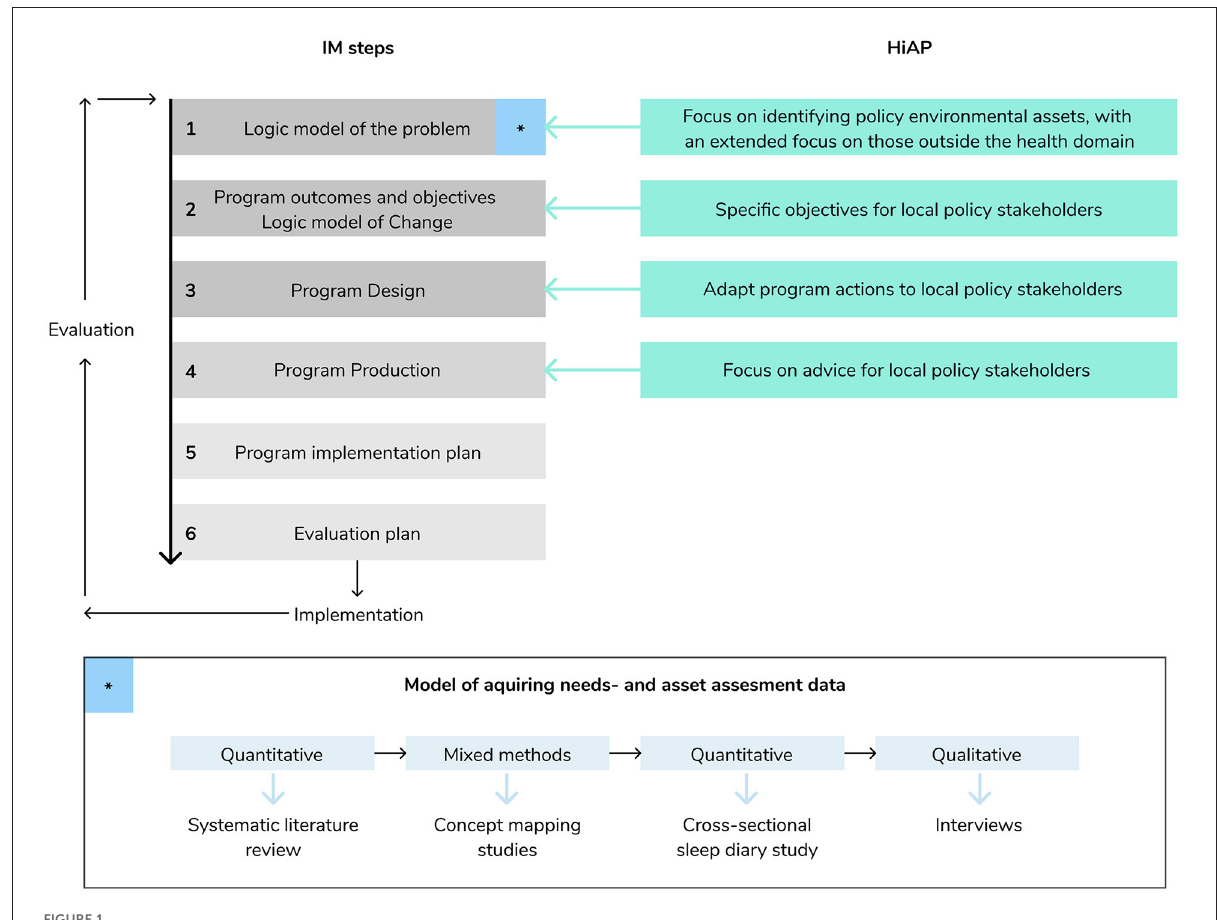
FIGURE1 Development process combining IM with